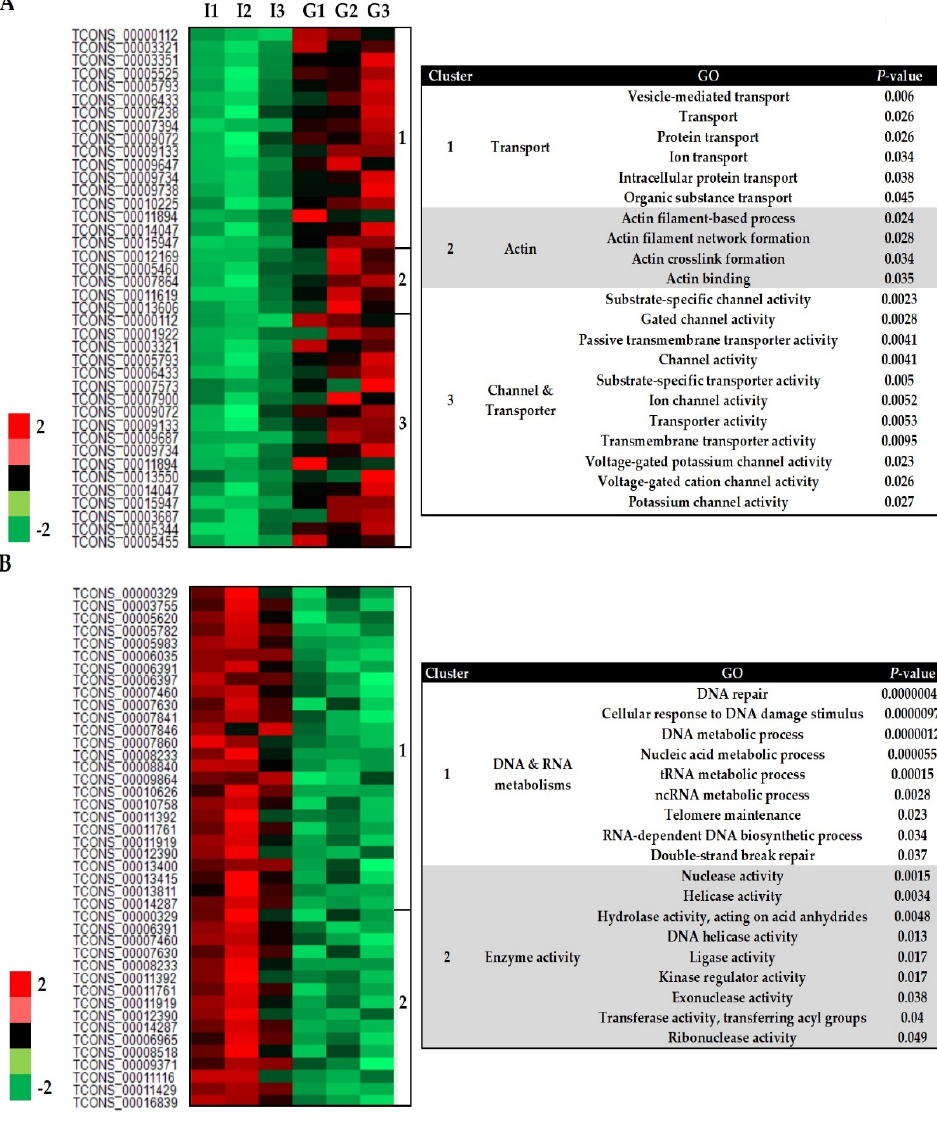
Figure 3. Heatmap (based on Z-scores of the normalized expression of transcripts) of differently expressed genes from S. subterranea (Gladiator vs. Iwa). The upregulated ( A ) and downregulated ( B ) genes and their related GO terms. G; Gladiator, I; Iwa.